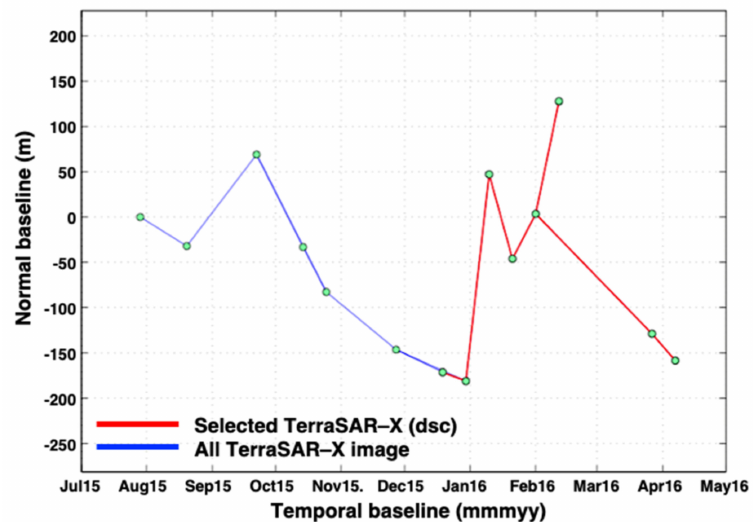
Figure 5. The baseline configuration of the TerraSAR–X